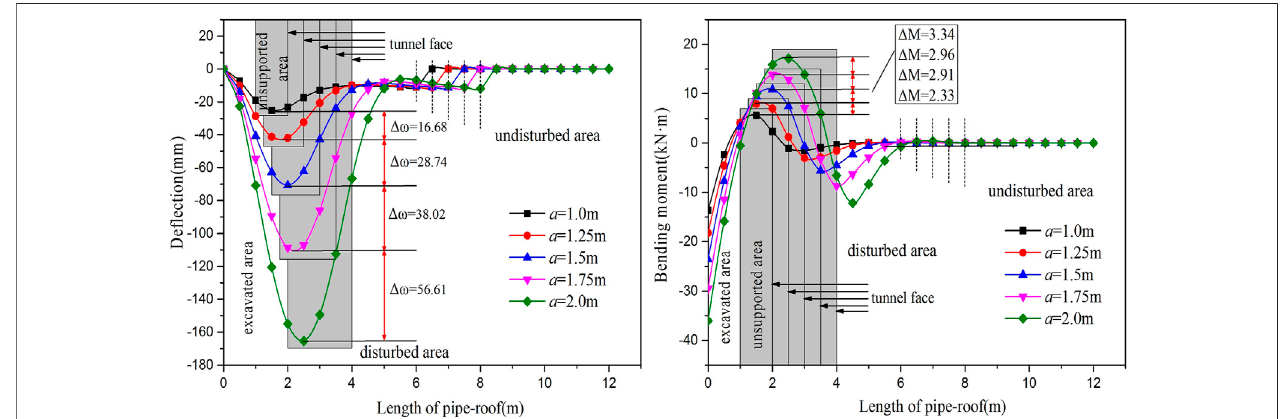
FIGURE 11 | The relation between excavation footage and de fl ection and bending moment when the diameter is 89 mm.